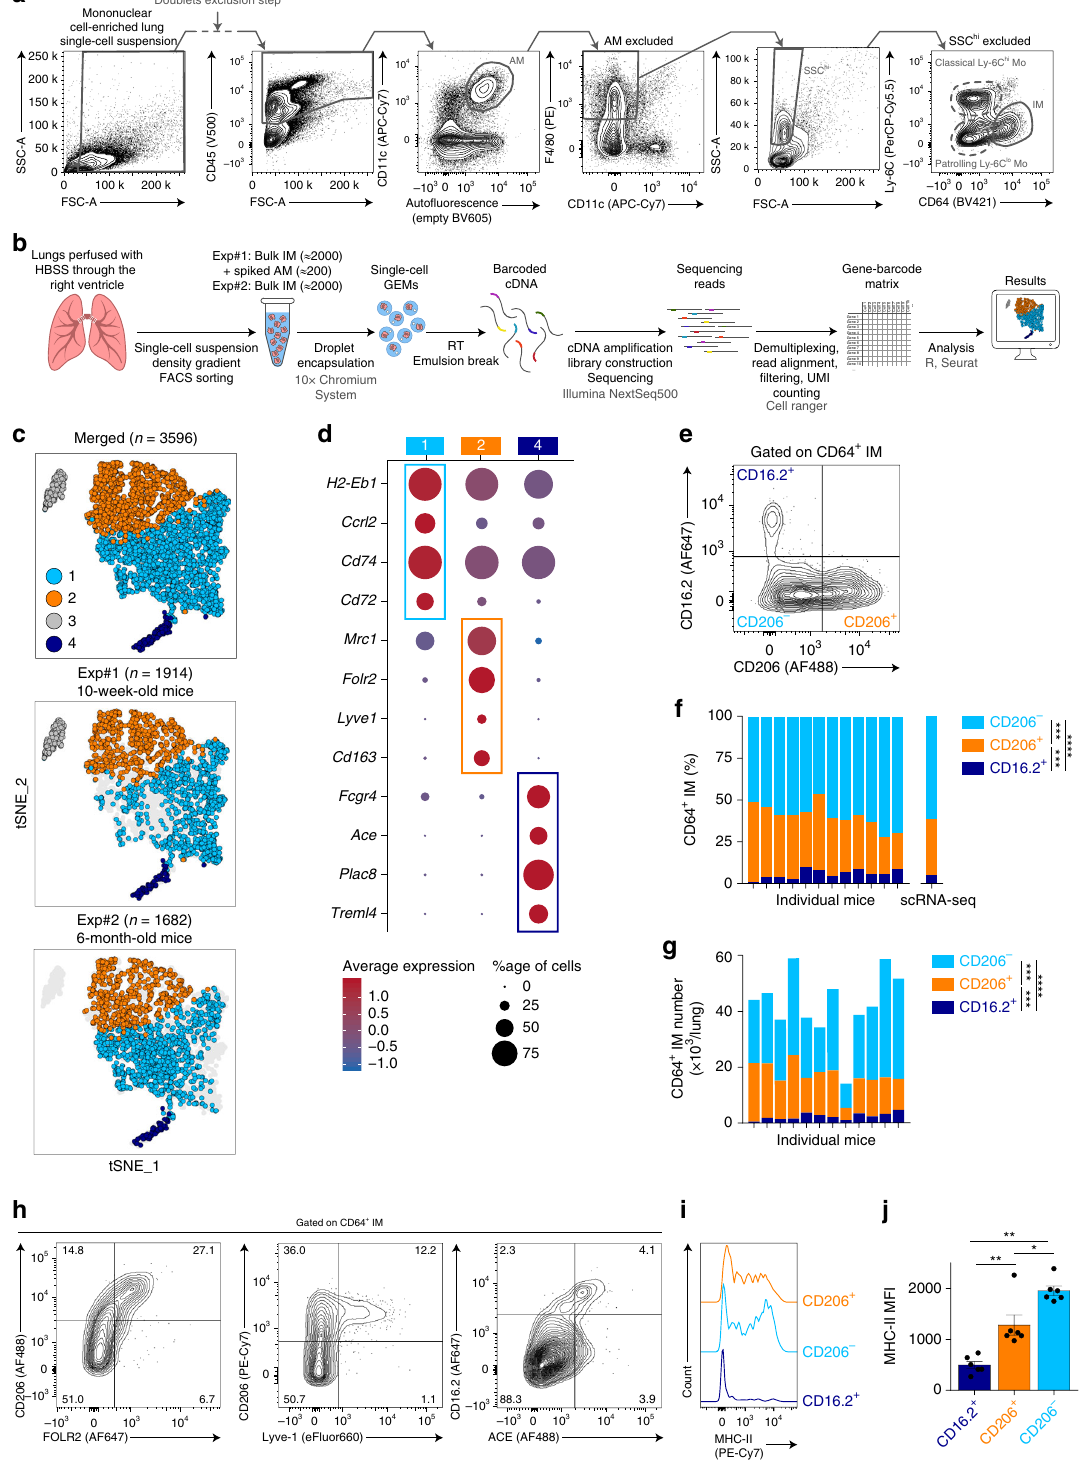
monocytes were labeled, con fi rming the existence of tissue- associated Ly-6C hi monocytes (Fig. 2e, f) 18,27 . However, the percentage of CD64 + CD16.2 + monocytes that were stained with the anti-CD45 in vivo exhibited a high variability and was signi fi cantly lower than the one of patrolling Ly-6C lo monocytes (Fig. 2e, f), suggesting that a substantial fraction of CD64 + CD16.2 + monocytes was truly located in the lung tissue.